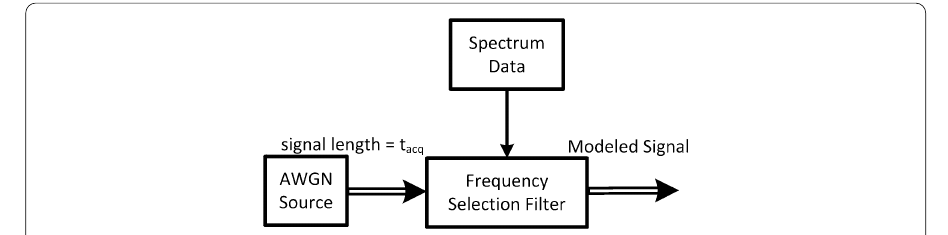
Fig. 14 Flow graph of reconstruction approach based on spectrum